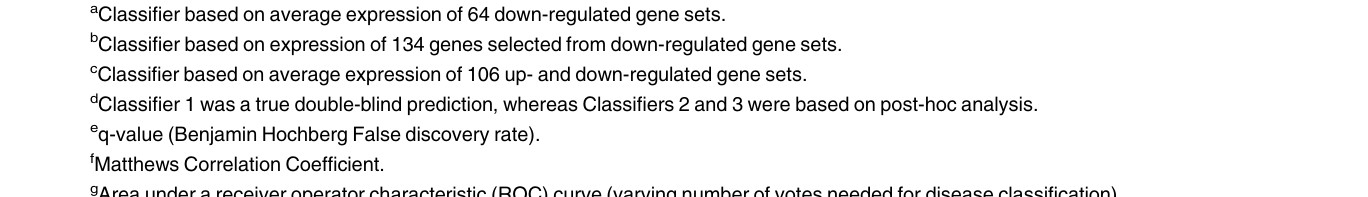
a Classifier based on average expression of 64 down-regulated gene sets. b Classifier based on expression of 134 genes selected from down-regulated gene sets. c Classifier based on average expression of 106 up- and down-regulated gene sets. d q-value (Benjamin Hochberg False discovery rate).